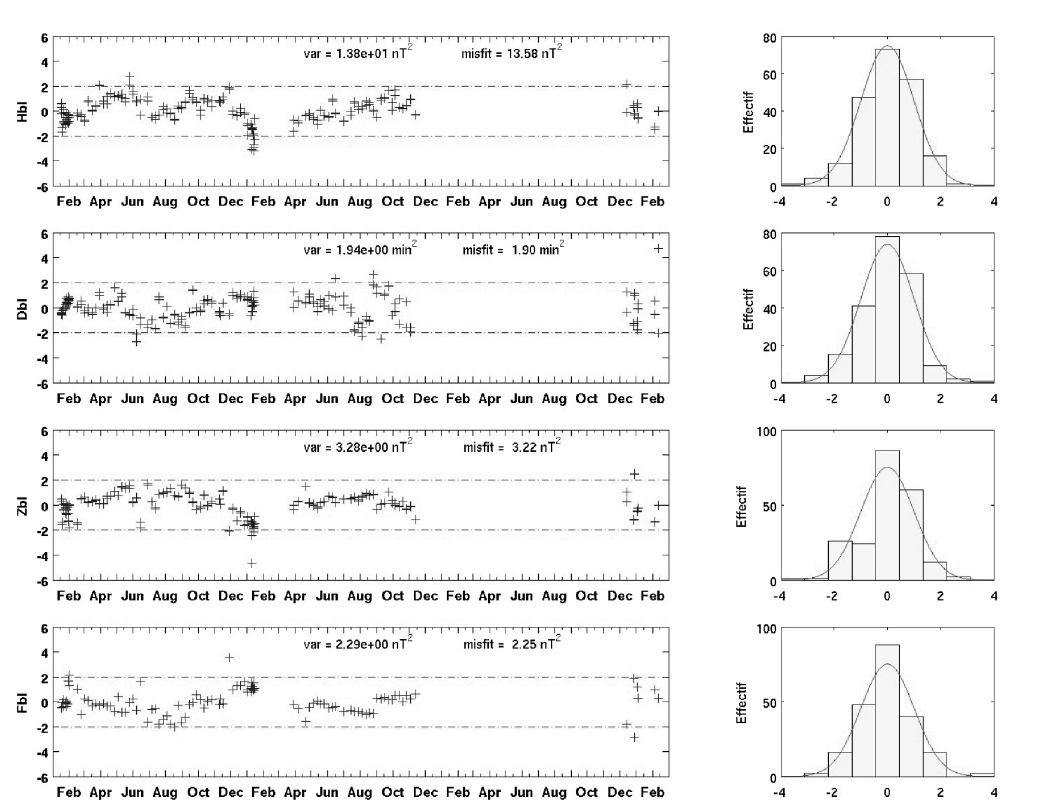
Fig. 5. Same as fig. 3 apart from the misfit parameter which is the usual square misfit in linear regression